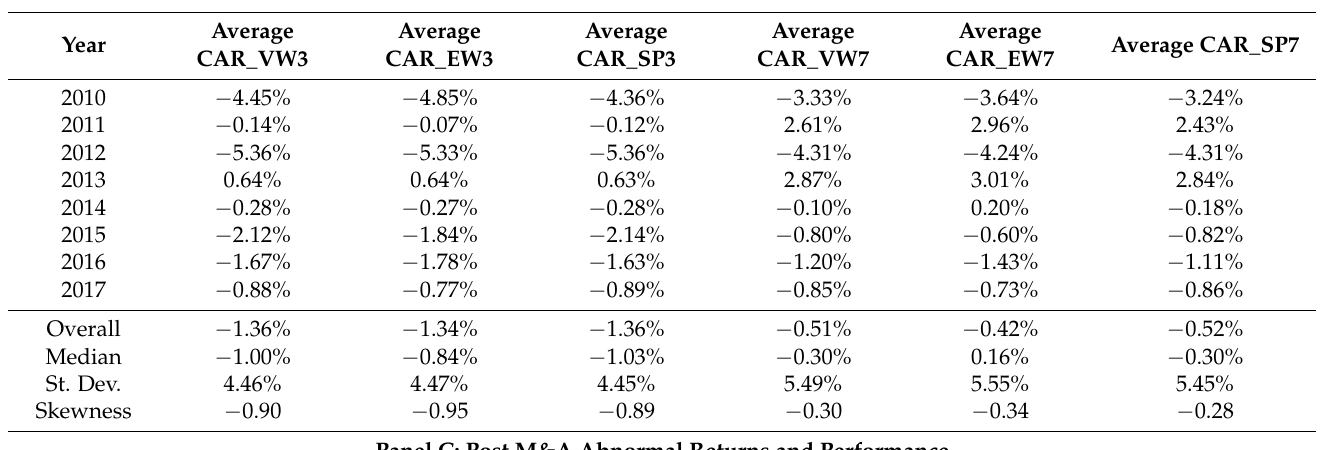
Table 1. Cont . Panel B: Announcement Period Abnormal Returns